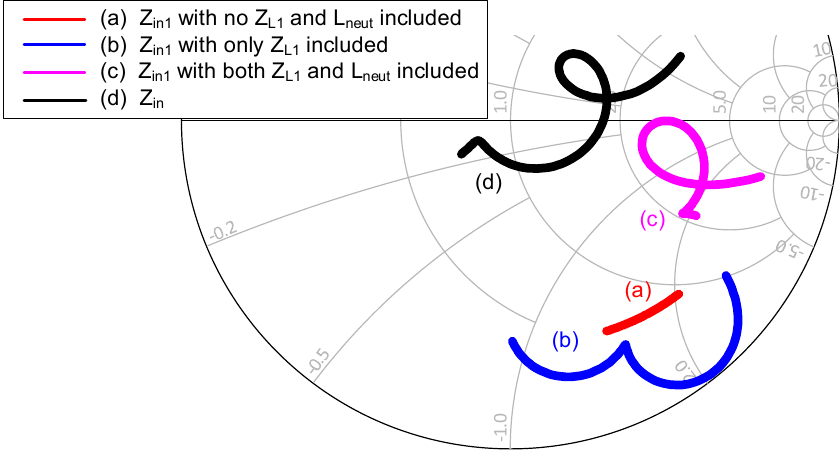
Figure 5. Loci of the input impedances from 26 to 40